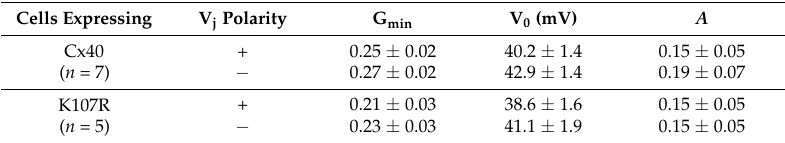
Figure 3. V j gating of AF-linked mutant GJs. ( A ) Dual whole-cell patch clamp was used to measure I j s in N2A cell pairs expressing Cx40, K107R, L223M, Q236H, or I257L in response to a series of V j pulses as indicated. Superimposed I j s for each mutant is shown; ( B ) normalized steady state junctional conductance, G j,ss , of the Cx40 mutants (black filled circles) and wildtype Cx40 (grey open circles) were plotted at different V j s. The G j,ss –V j plot of each mutant was fitted with a two-state Boltzmann equation at each V j polarity (smooth black lines). Boltzmann fittings of G j,ss –V j plot of wildtype Cx40 (smooth grey dashed lines) were obtained and superimposed on each plot for comparison. The number of cell pairs is indicated. Table 1. Boltzmann fitting parameters for V j gating of AF-linked